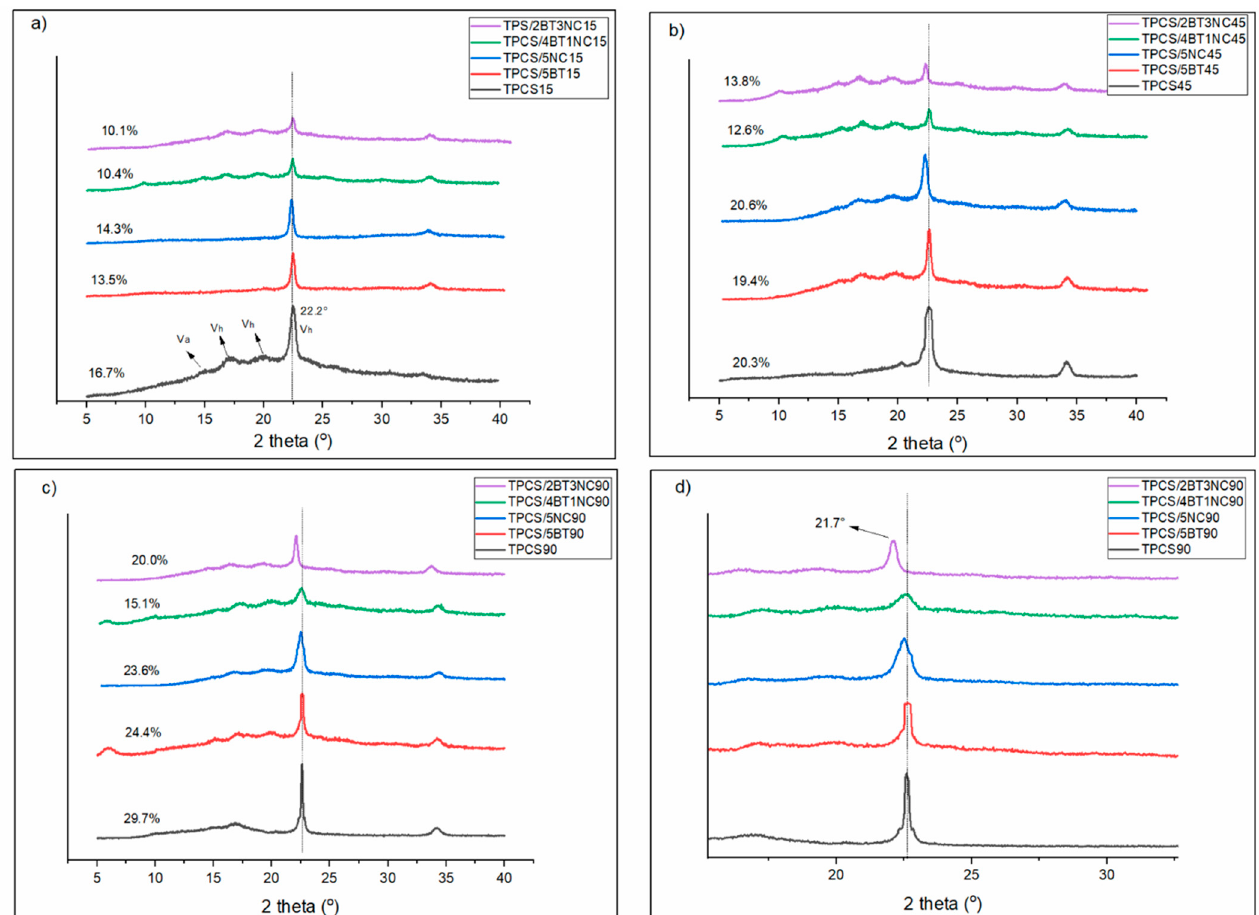
Figure 4. XRD scan for virgin TPCS, TPCS-C, and TPCS-HC films aged for ( a ) 15, ( b ) 45, and ( c ) 90 days from 2 θ = 5.0–40.0° and ( d ) 90 days from 2 θ = 10.0–30.2°.